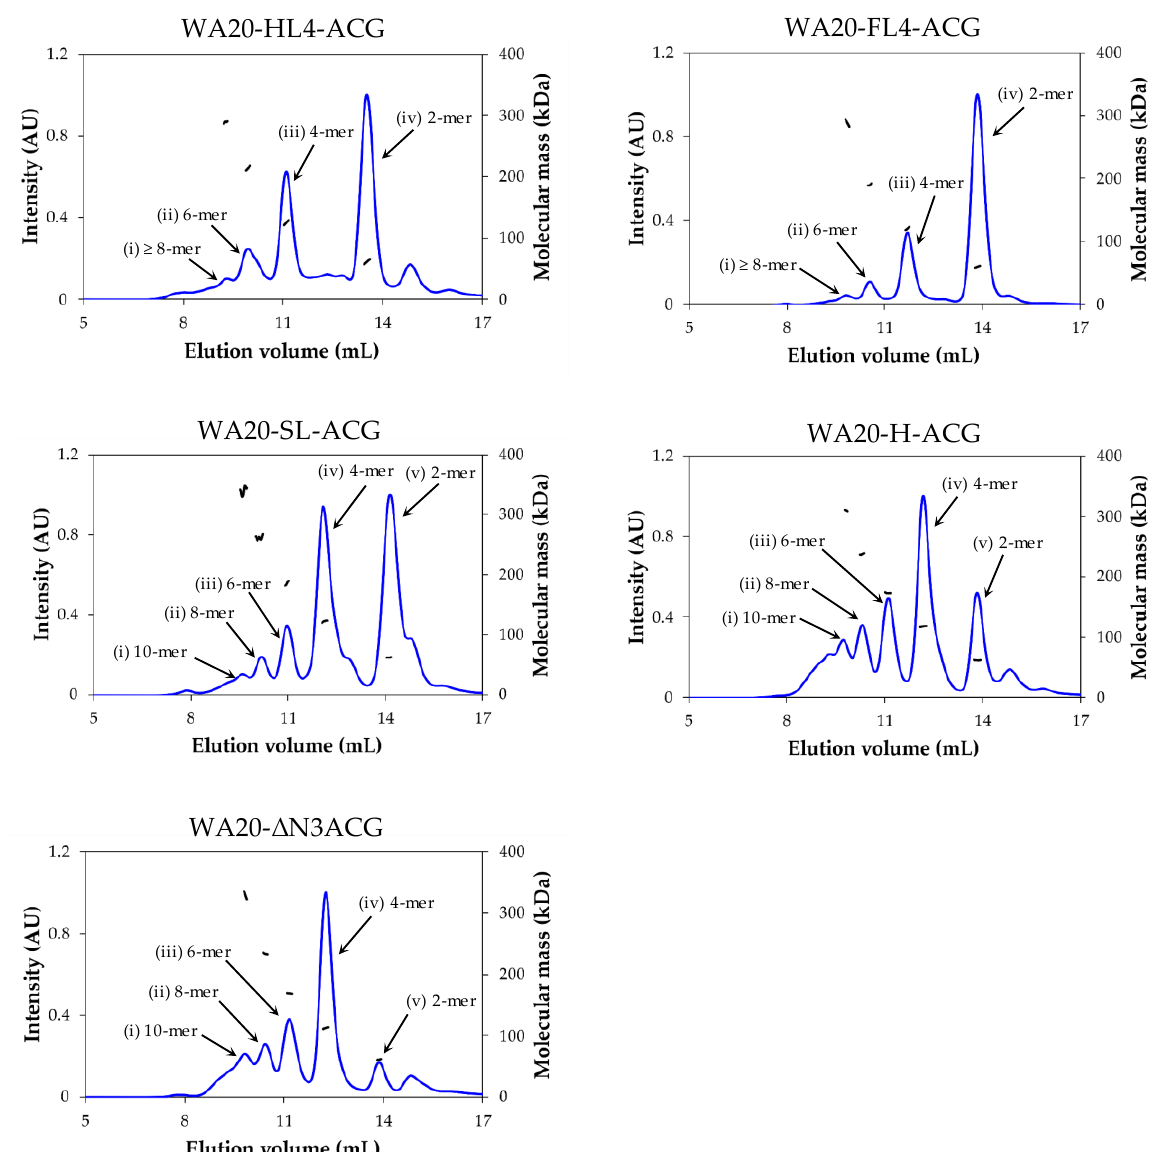
Figure 2. SEC–MALS profiles of the five lectin nano-blocks. The blue and the black lines represent the normalized intensity of UV absorbance ( A 280 nm ) and the molecular mass of each peak, respec- tively.